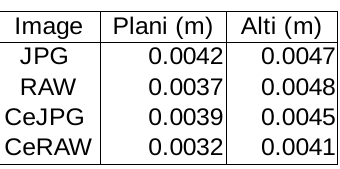
Geometric precision when using jpg and raw images with and without contrast enhancement when computing tie-points ( CeJPG , CeRAW - contrast enhanced JPG and, respectively, RAW images; plani, alti – planimetric and altimetric